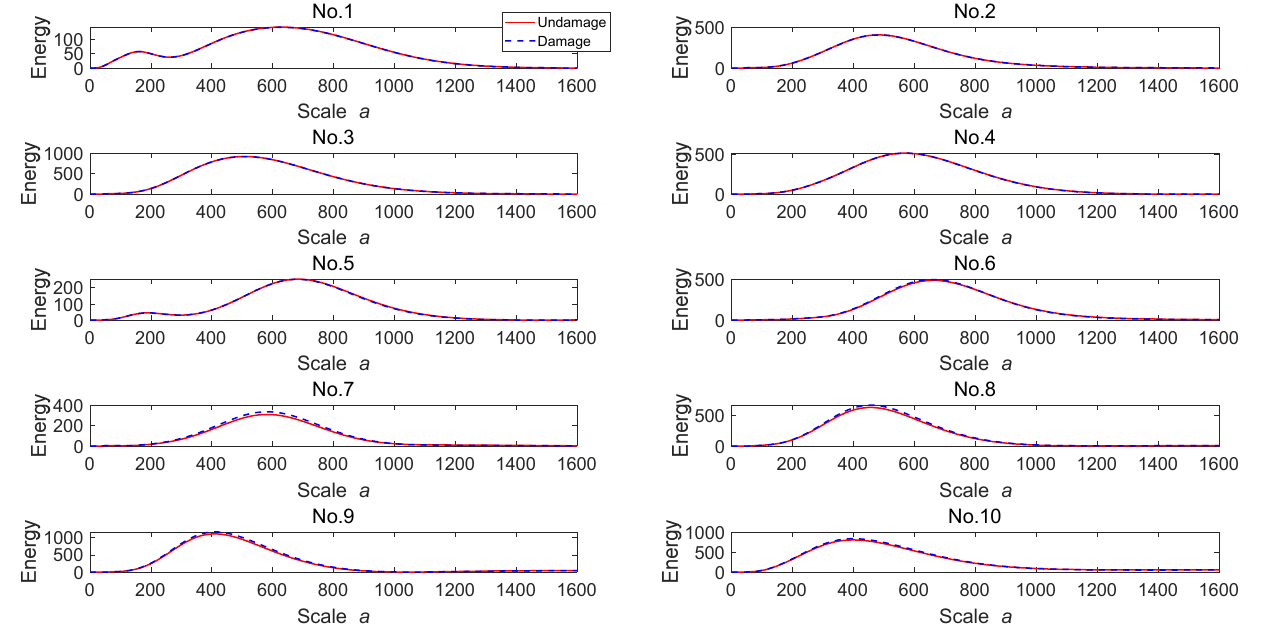
Figure 11. Wavelet energy comparison of component signals .